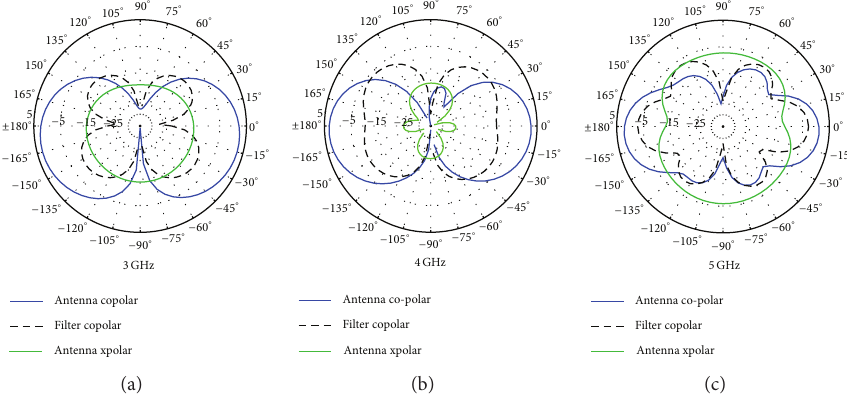
Figure 11: Simulated radiation pattern of the antenna and the filter in the E-plane (10dB/div).